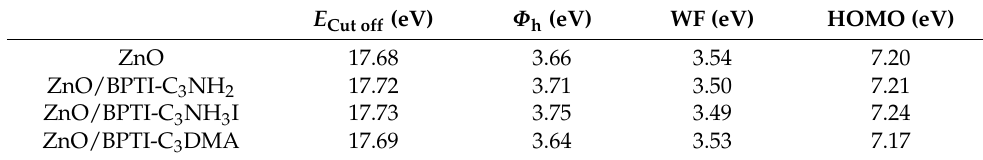
Figure 4. ( a ) UPS spectra of ZnO films prepared with and without IFLs and ( b ) energy levels of the materials. Table 3. WFs of ZnO films prepared with and without IFLs, determined using UPS.